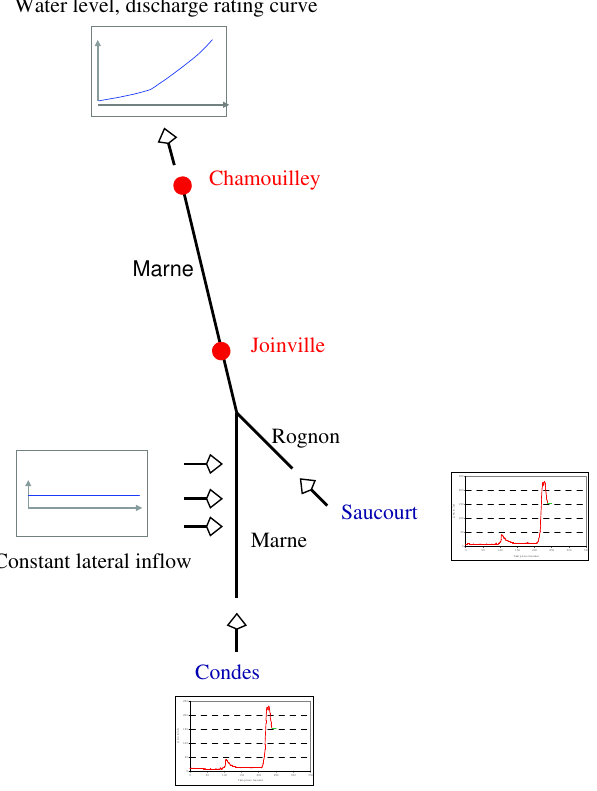
Fig. 7. The Marne Vallage catchment with the measurement stations in red and the upstream stations in